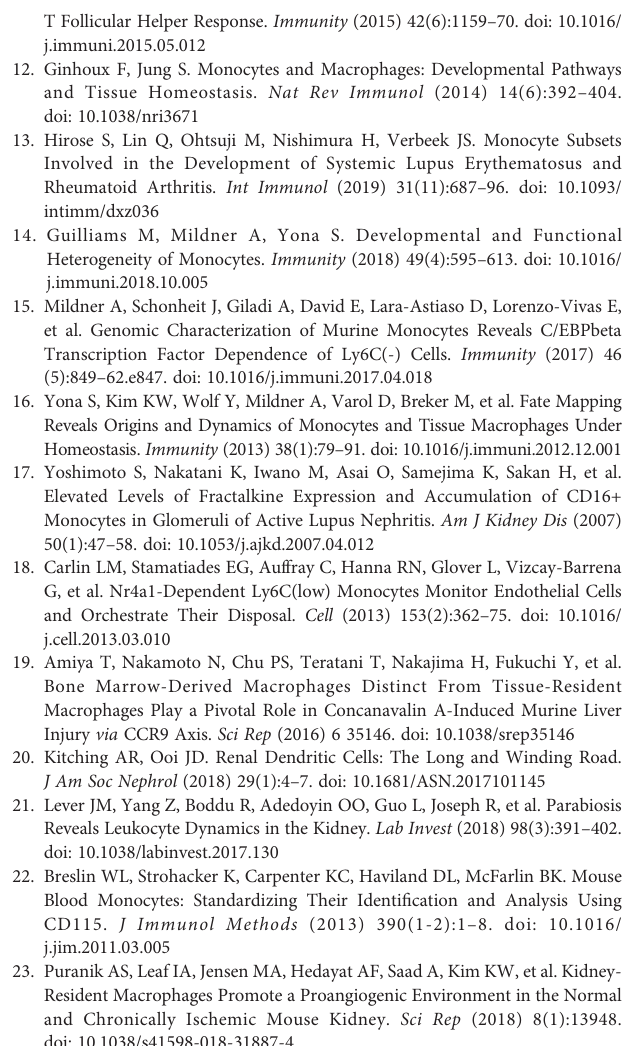
Supplementary Figure 3 | Gating strategy to sort blood monocytes and kidney monocyte-like cells for RNA-seq analysis. Blood monocytes (Ly6C hi and Ly6C lo ) and kidney monocyte-like cells were sorted from control and IMQ-induced lupus mice.Lupuslike-diseasewasinducedbytheapplicationof20mgIMQthreetimesa week for 7 weeks. Representative plots of samples from control mice are shown. Supplementary Figure 4 | RNA-seq analysis of peripheral monocytes and kidney Ly6C lo monocyte-like cells. Cluster analysis of differentially-expressed genes (DEG) classi fi ed genes into 20 clusters. B-Ly6C hi : blood Ly6C hi monocytes, B- Ly6C lo : blood Ly6C lo monocytes, K-Ly6C lo : kidney Ly6C lo monocyte-like cells. Supplementary Figure 5 | Ly6C lo monocytes and monocyte-like cells are increased in lupus NZB/NZW mice. (A) Ly6C lo monocytes are increased in the blood of aged NZB/NZW mice. Monocyte-like cells also tended to be increased in the lymph nodes. (B) Ly6C lo monocyte-like cells are increased in the kidneys of aged NZB/NZW mice. (C) Application of topical IMQ (10 mg, three times a week for 4 weeks) to NZB/NZW mice increased Ly6C lo monocyte and monocyte-like cells in the peripheral blood and lymph nodes. (D) Application of topical IMQ increased Ly6C lo monocyte-like cells in the kidneys of NZB/NZW mice. The numbers in the graph indicate the cell number in 100,000 live CD45 + cells. Symbols represent individuals and horizontal lines indicate the mean and SEM. *P < 0.05, **P < 0.01, and ***P < 0.01 by Student ’ s t -test.